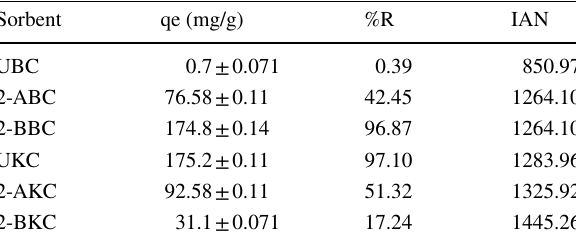
Table 2 Methylene number and iodine number values